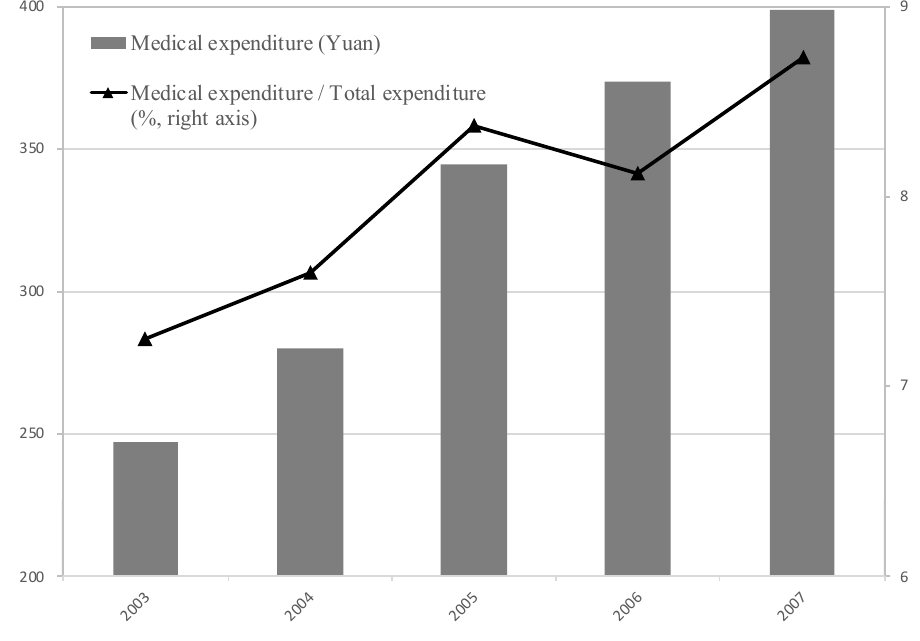
Figure 1. Medical Expenditure from 2003 to 2007.